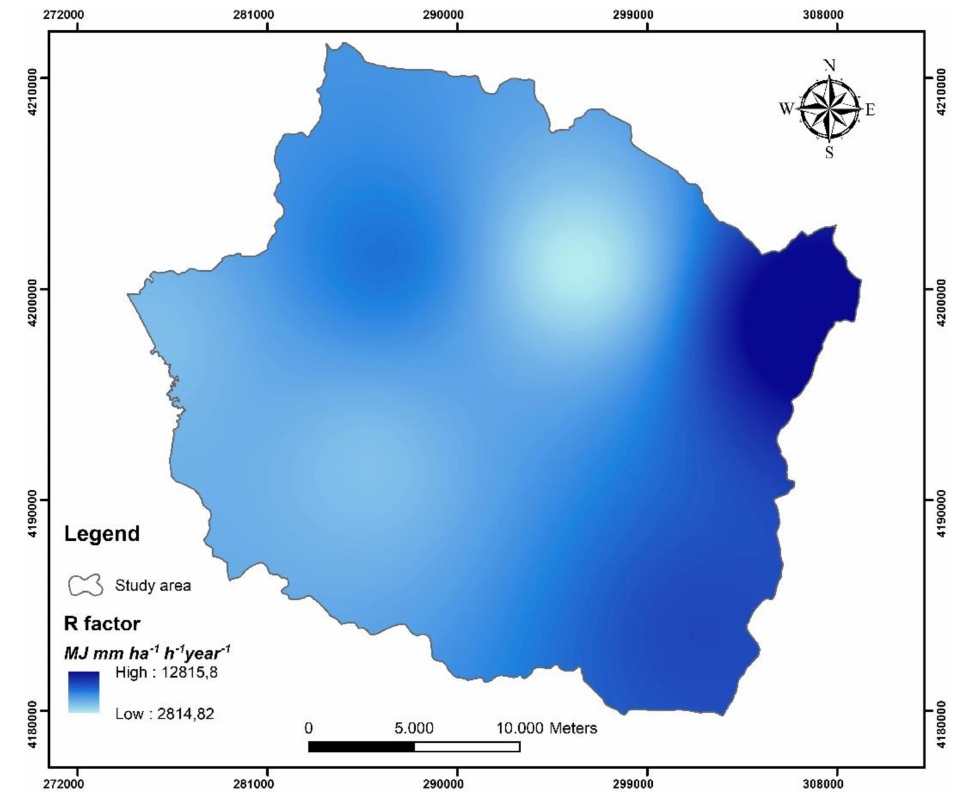
Figure 8. Rainfall-runo ff erosivity factor R map of the pilot